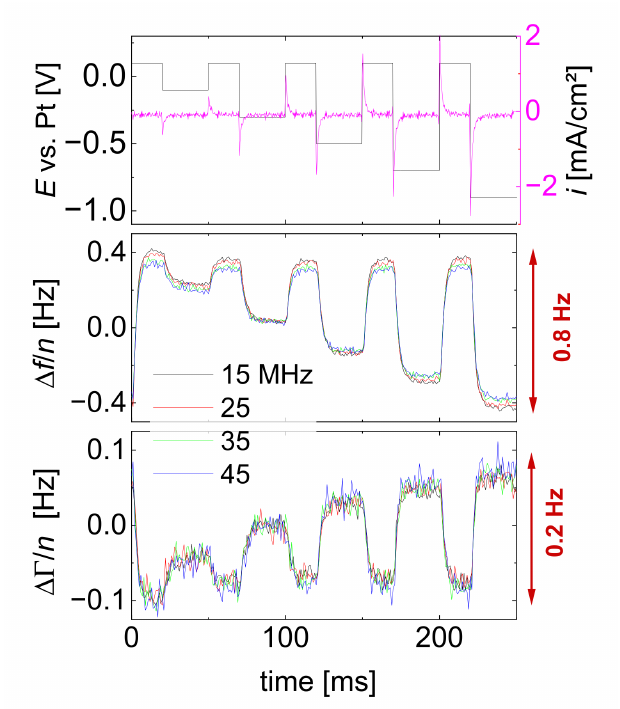
Figure 6. An example, where an EQCM responds to changes in a liquid’s near-surface viscosity. A solution of electrochemically inert ions was subjected to voltage steps, as shown at the top. The current recharges the diffuse double layer. The shifts in frequency are much larger than the shifts in bandwidth, and ∆ f / n is similar on the different overtones. Typically, such a Sauerbrey-type behavior would be interpreted as being caused by adsorption, but increased viscosity in the diffuse double layer is equally possible. The kinetics suggests that altered viscosity makes a larger contribution to the overall frequency shift than adsorption. For details, see ref. [28]. The nonzero shift in ∆Γ shows that there is a small elastic component in the double layer’s response. Adapted from ref.